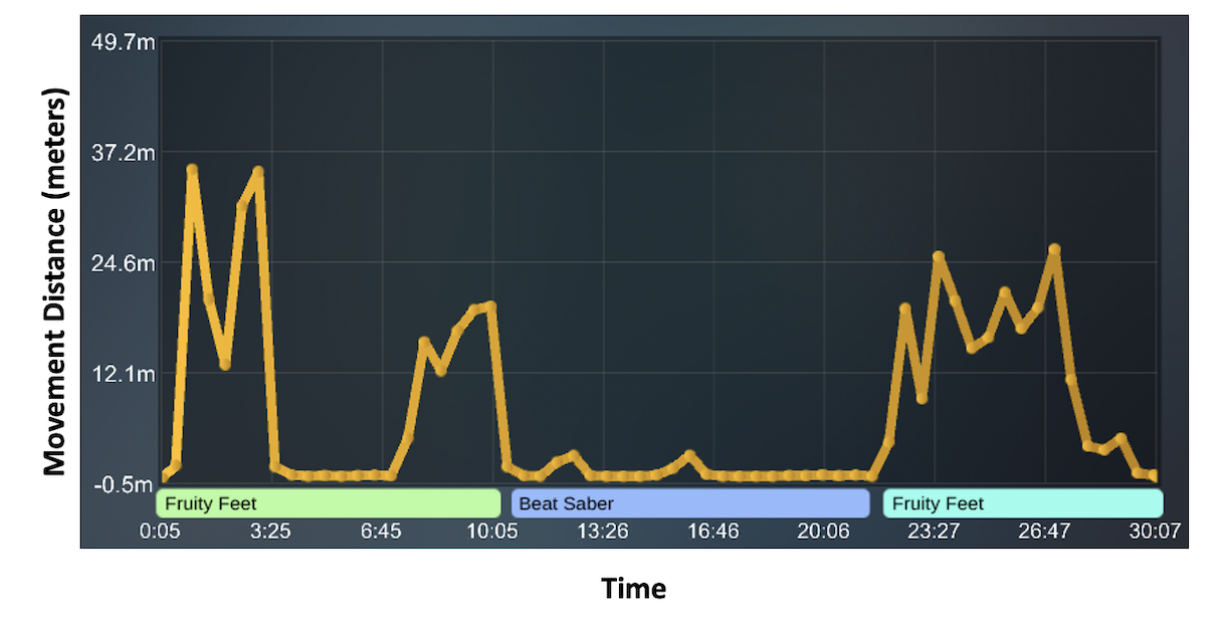
Figure 6. VR Clinical Comparison Research Tool. The screen provides a graph of the patient’s progress over time during their VR session while using Fruity Feet and a commercially used program (eg, Beat Saber) and then utilizing Fruity Feet once again. The graph shows increased movement of the lower left extremity (yellow line) while engaged in Fruity Feet. The lower left extremity movement reduces with other VR programming (eg, Beat Saber). VR: virtual